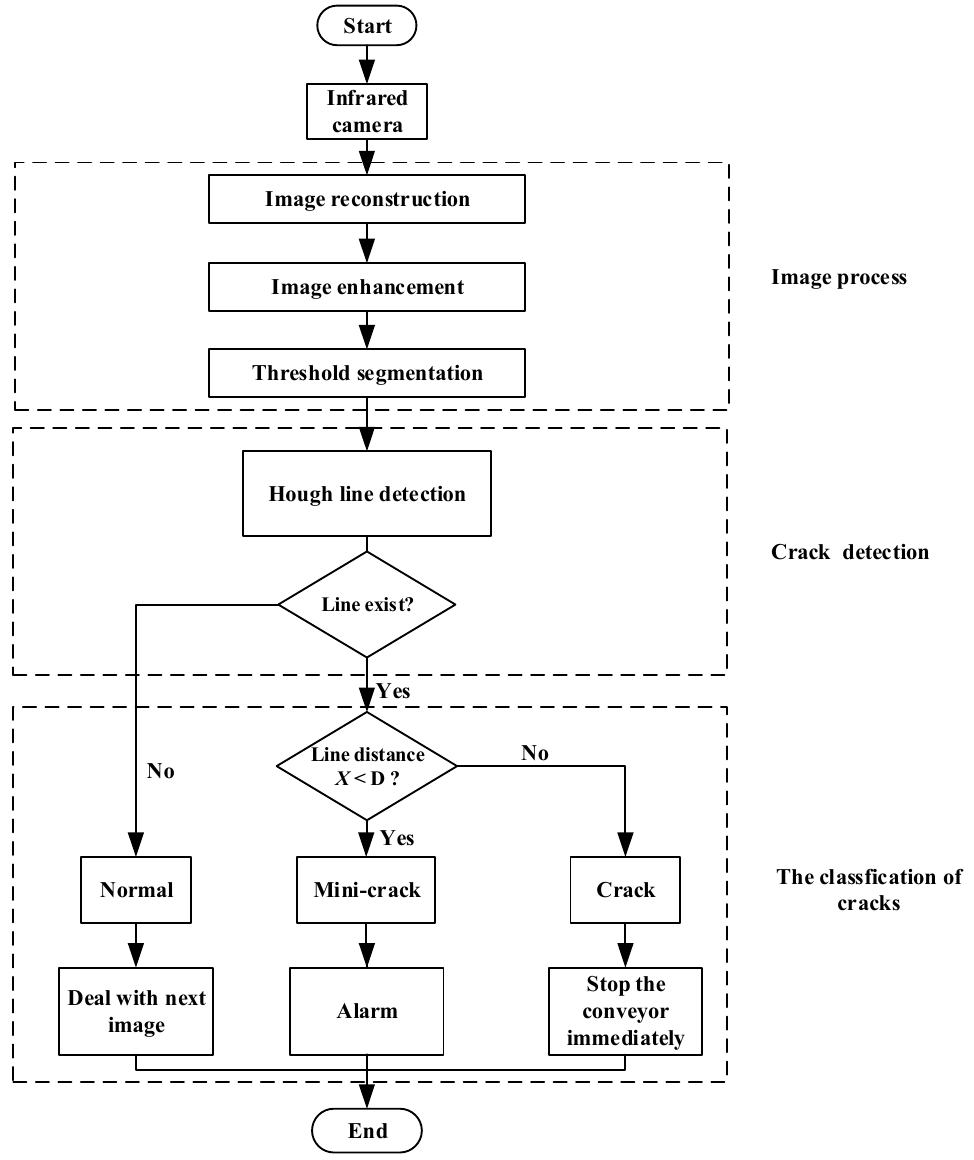
Figure 7. Flow chart of mini-crack detection process of the conveyor belt.